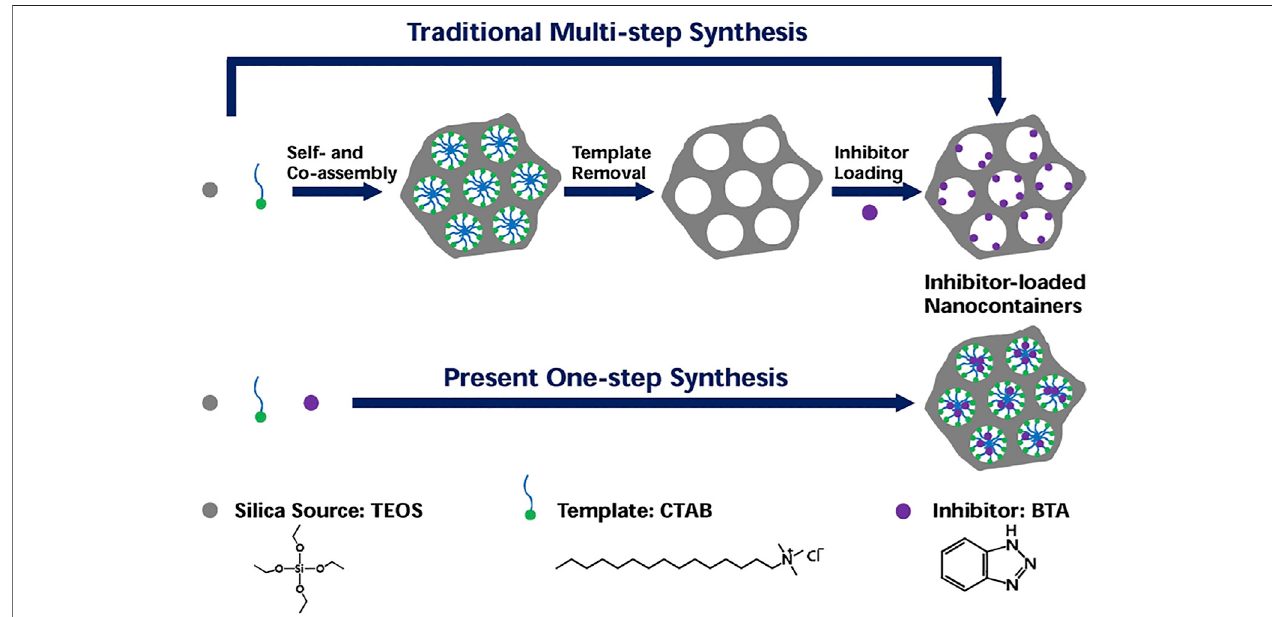
FIGURE 4 | Schematic illustration of MSN loaded with corrosion inhibitors synthesized by traditional multistep method and current one-step methods in this work (Xu et al., 2018).